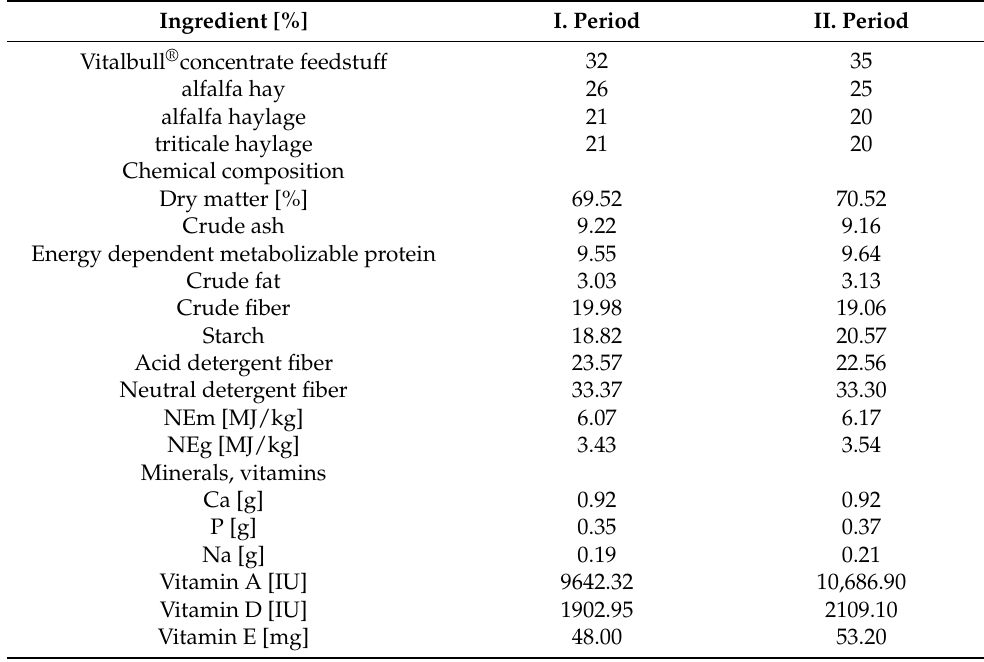
Table 1. Ingredients and chemical composition related to dry matter [DM] as well as energy [MJ/kg; %DM basis] of the total mixed